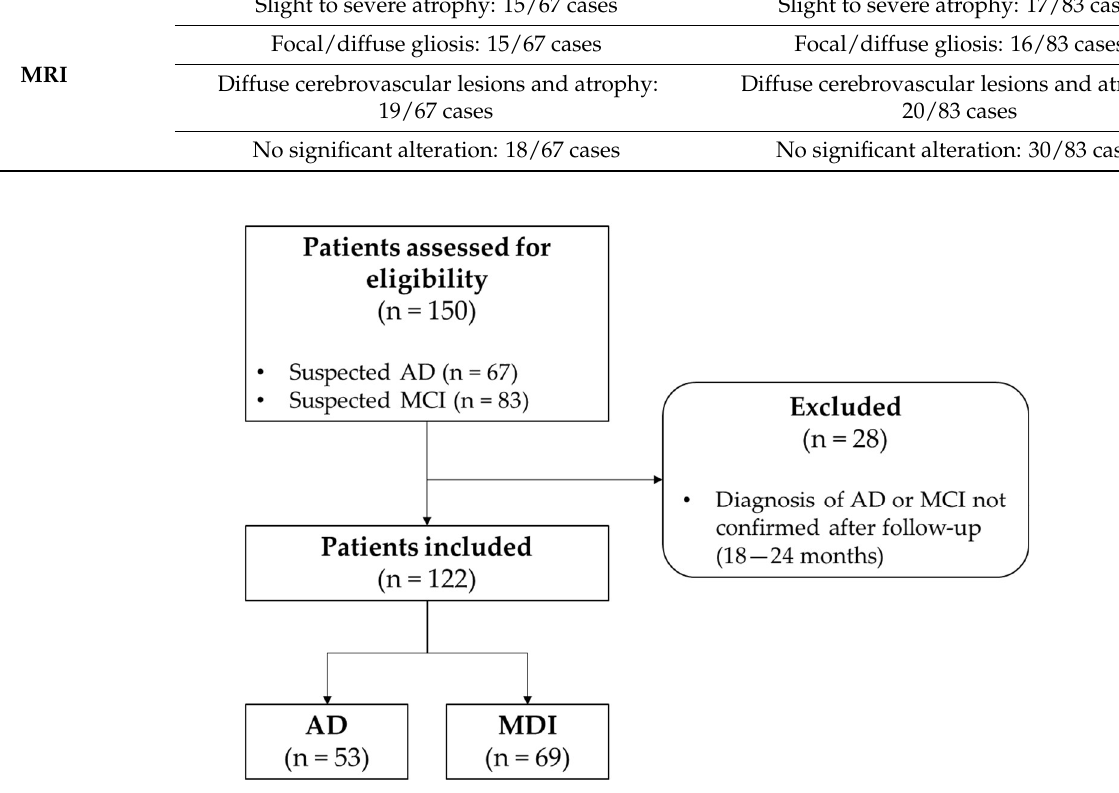
Figure 1. STARD diagram for the study population. Figure 1 . STARD diagram f or the study population . Figure 1 . STARD diagram f or the study population .